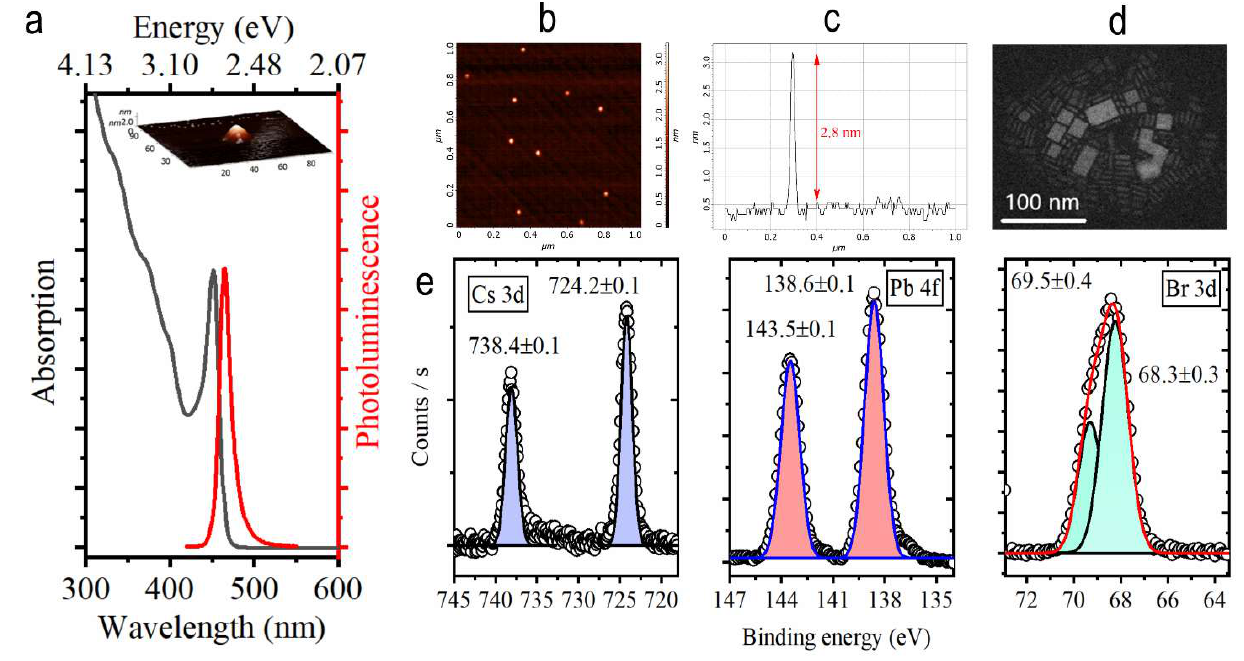
Figure 1. ( a ) Absorption and PL spectra of CsPbBr 3 NPls. The inset shows a 3D AFM image. ( b ) AFM image of CsPbBr 3 NPls and ( c ) the corresponding height profile. ( d ) HAADF-STEM image of CsPbBr 3 NPls. ( e ) XPS spectra for Cs, Pb, and Br